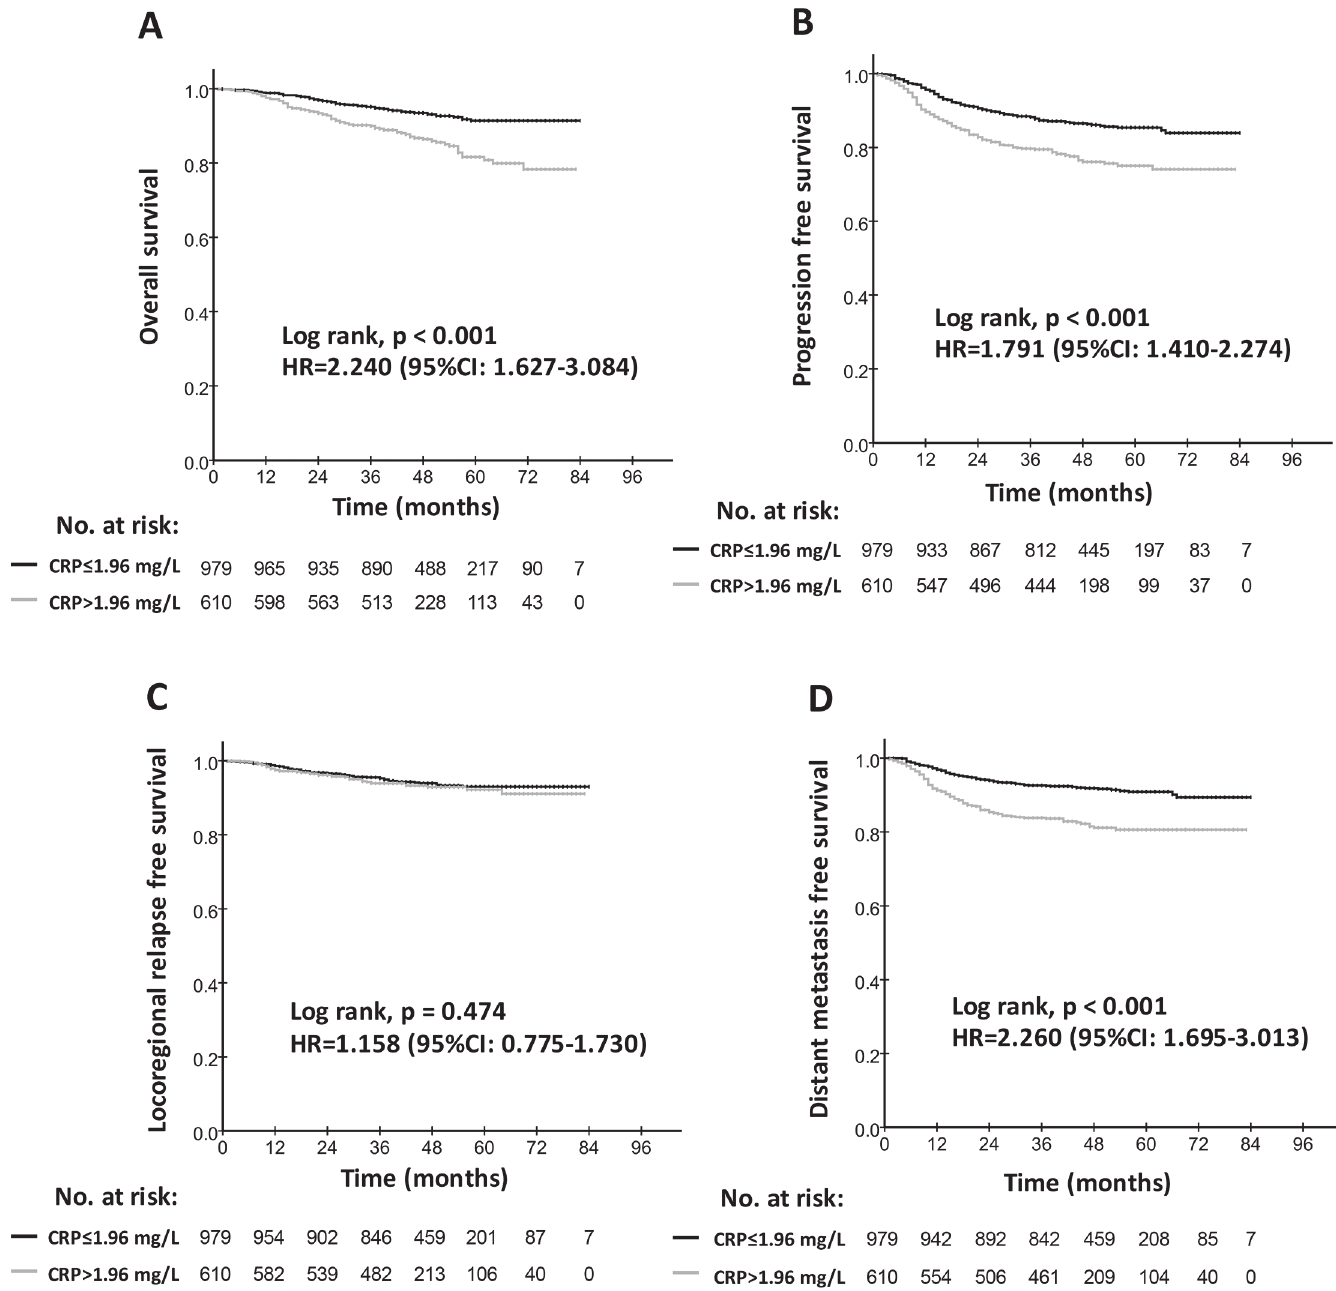
Fig 1. Kaplan-Meier survival curves for the low hs-CRP group ( (cid:3) 1.96 mg/L) and the high hs-CRP group ( > 1.96 mg/L) in the study population. Overall survival rates (A), progression-free survival rates (B), locoregional relapse-free survival (C) and distant metastasis-free survival rates (D) were compared in the entire cohort of NPC patients. Hazards ratios (HRs) were calculated using the unadjusted Cox proportional hazards model. P values were calculated using the unadjusted log-rank test.